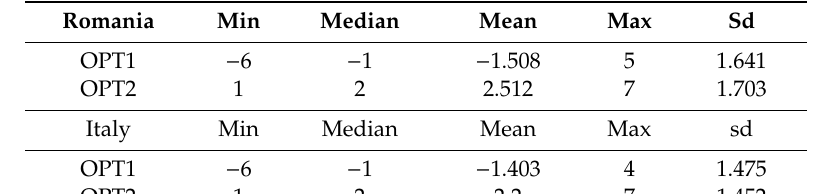
Table 4. Descriptive statistics of the optimism indices.